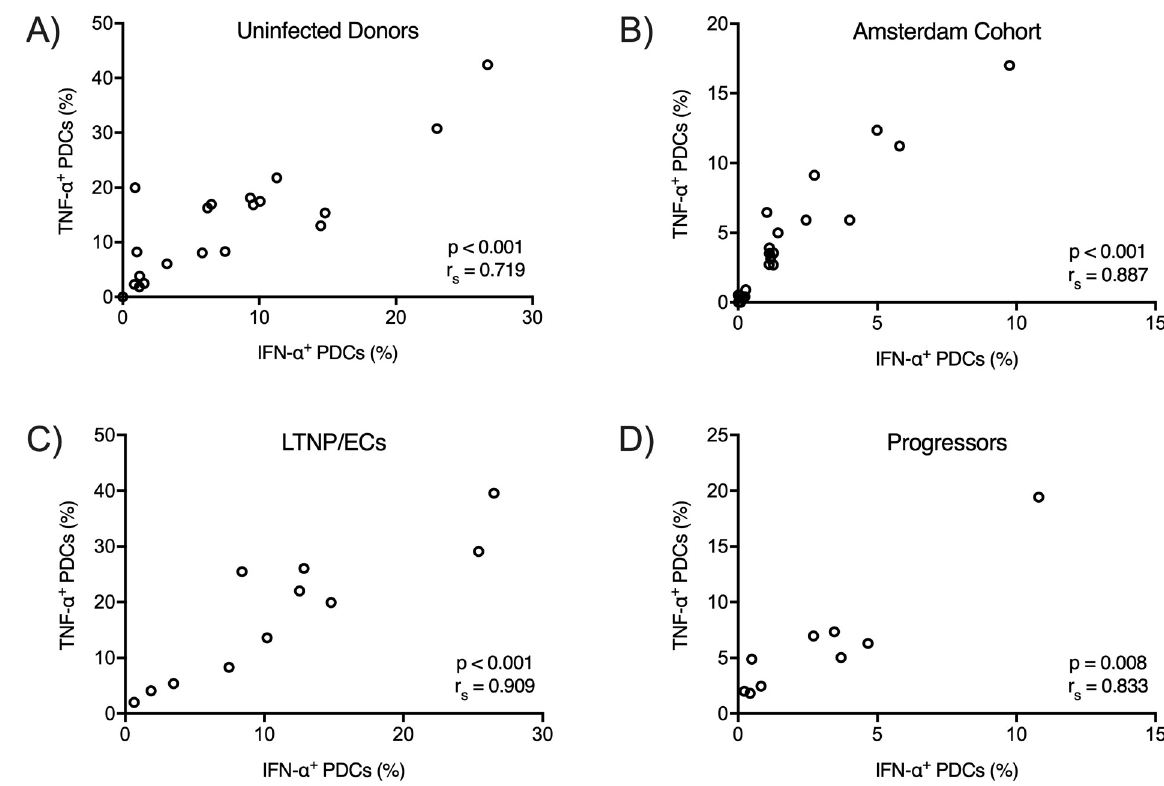
Fig 4. IFN- α and TNF- α production correlates in PDCs following TLR9 receptor ligation by CpG A. PDC TLR9 receptors were stimulated by CpG A, and cytokine secretion was inhibited after 4 hours. Anti-IFN- α and anti-TNF- α antibodies were used to measure intracellular IFN- α and TNF- α production by flow cytometry. P and r s values were calculated by the Spearman rank correlation. https://doi.org/10.1371/journal.pone.0225806.g004 both LTNP/ECs and progressors (r = 0.90, p < 0.001 (Fig 5A); r = 0.93, p < 0.001 respectively s s (Fig 5B)), consistent with the results observed when viral particles were used to stimulate PDCs. This result suggests that differences in IFN- α production in different cohorts were not due to variations in viral entry through CD4 binding. Rather, the results are most consistent with variations in IFN- α production modulated at the level of the TLR7-MyD88 complex.